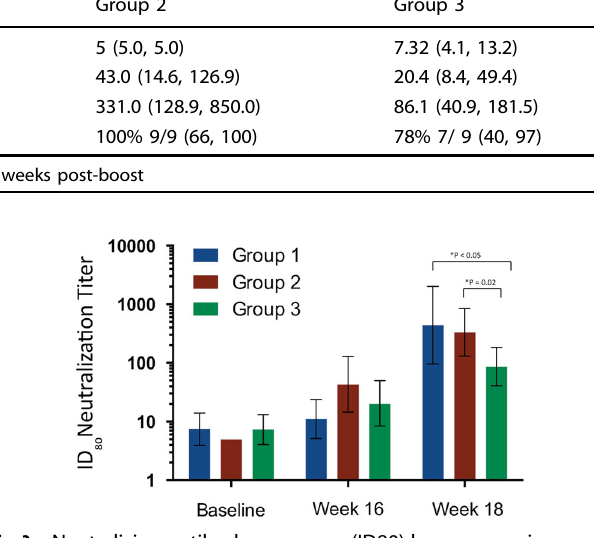
Fig. 3 Neutralizing antibody responses (ID80) by group assignment. Geometric mean titers and 95% con fi dence intervals are shown at baseline, the day of boost, and 2 weeks following the H7N9 boost. Group 1 received H7 DNA at day 0 and H7N9 MIV at week 16. Group 2 received both H7 DNA and H7N9 MIV prime at day 0 and H7N9 MIV at week 16. Group 3 received H7N9 MIV at day 0 and at week 16. Groups with statistically signi fi cant responses are marked with corresponding p -values (Student ’ s t -test in log